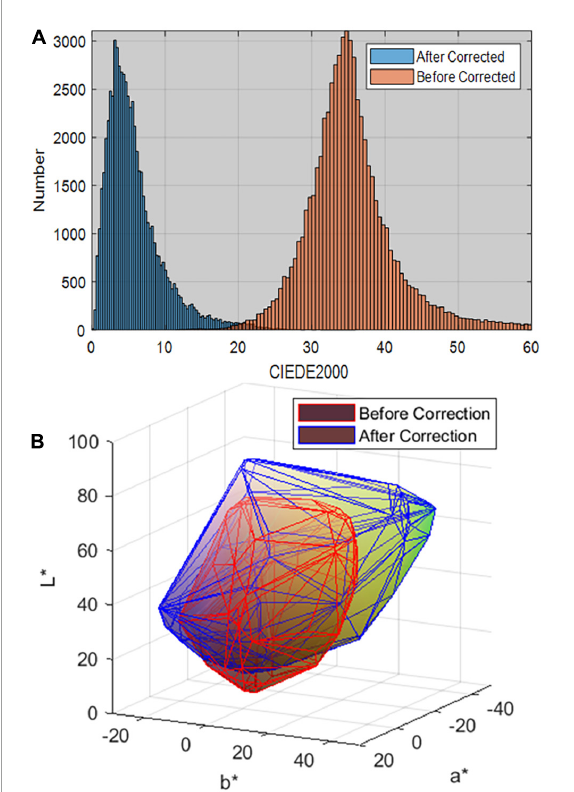
FIGURE11 (A) Comparison of the CIEDE2000 color difference histogram before and after correction, (B) visual of the color gamut in CIE LAB color space.